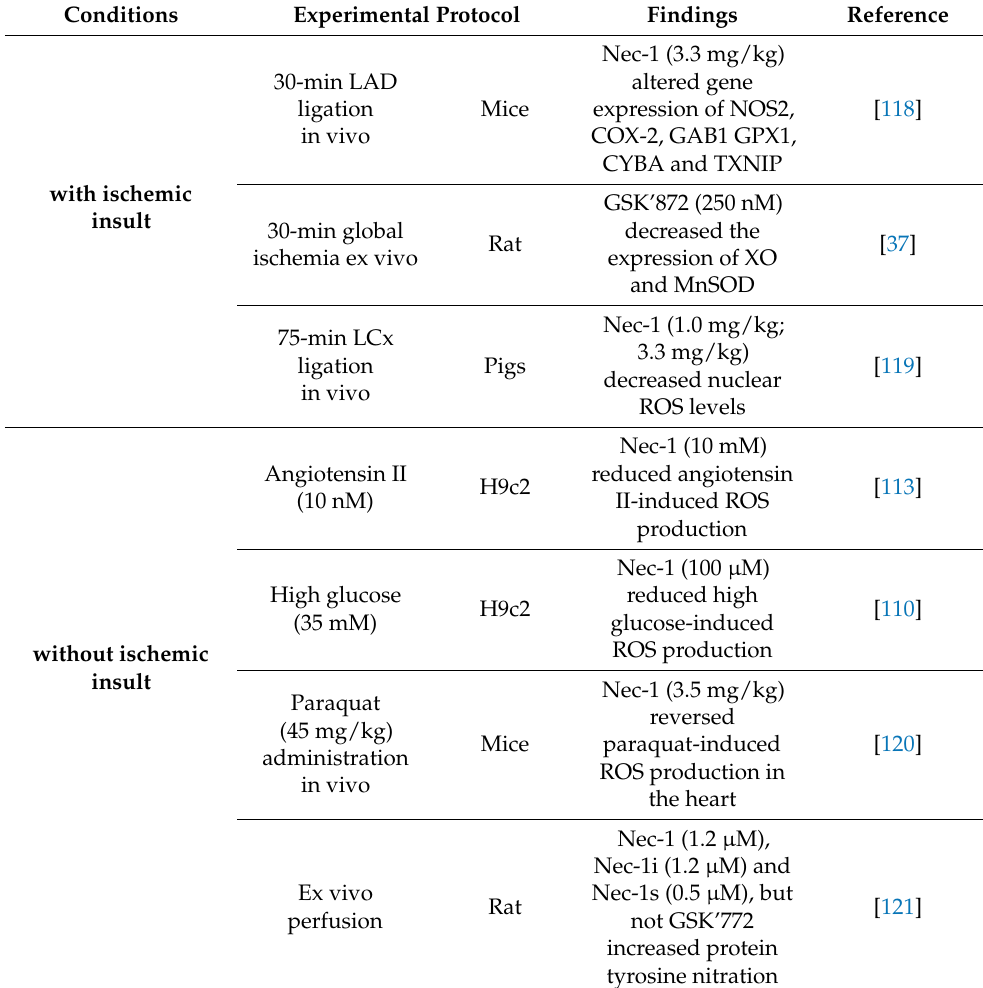
Table 3. List of studies illustrating an ability of necroptosis inhibitors to modulate oxidative stress.